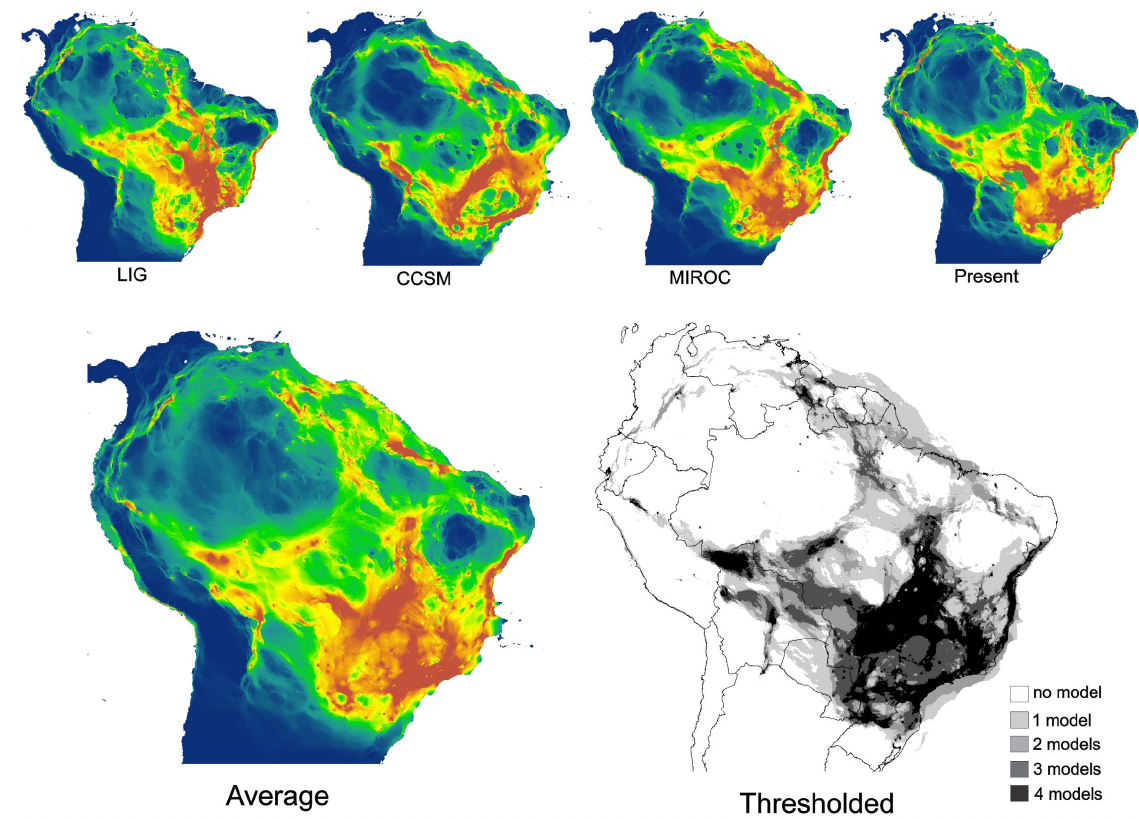
Figure 6. Estimated conductance maps for Dendropsophusminuts complex. Conductance maps constructed with the program Circuitscape. Conductances were estimated according to a spacial distribution modeling for the D. minutus complex projected to four different climatic scenarios. Conductance maps were averaged and thresholded to show stable dispersal corridors (see methods for details).